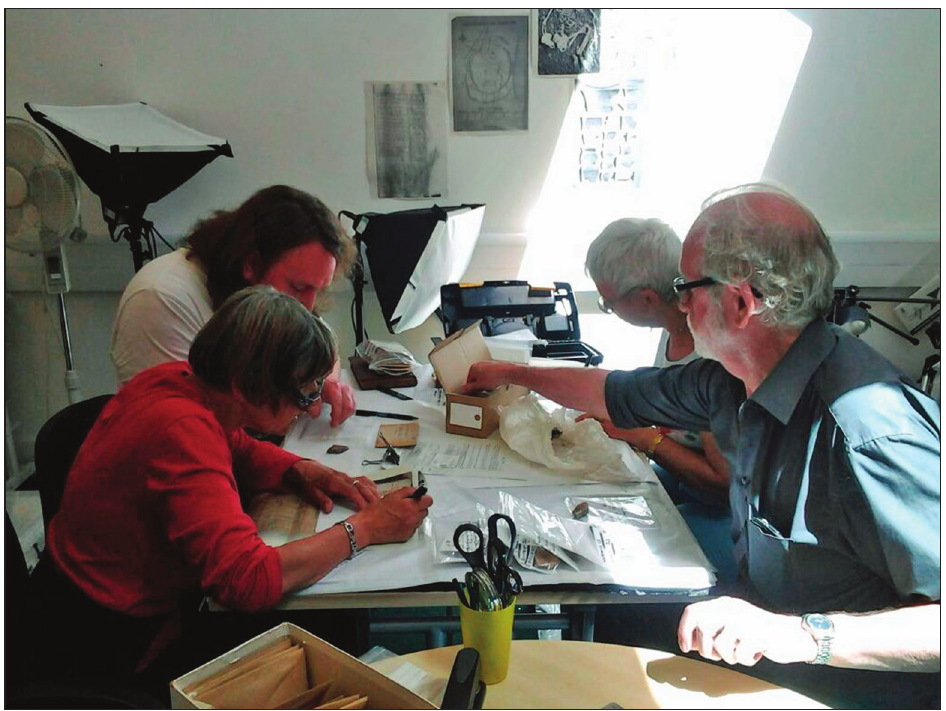
Figure 2: Project volunteers repacking the archive. (Photo: Royal Pavilion and Museums, Brighton and